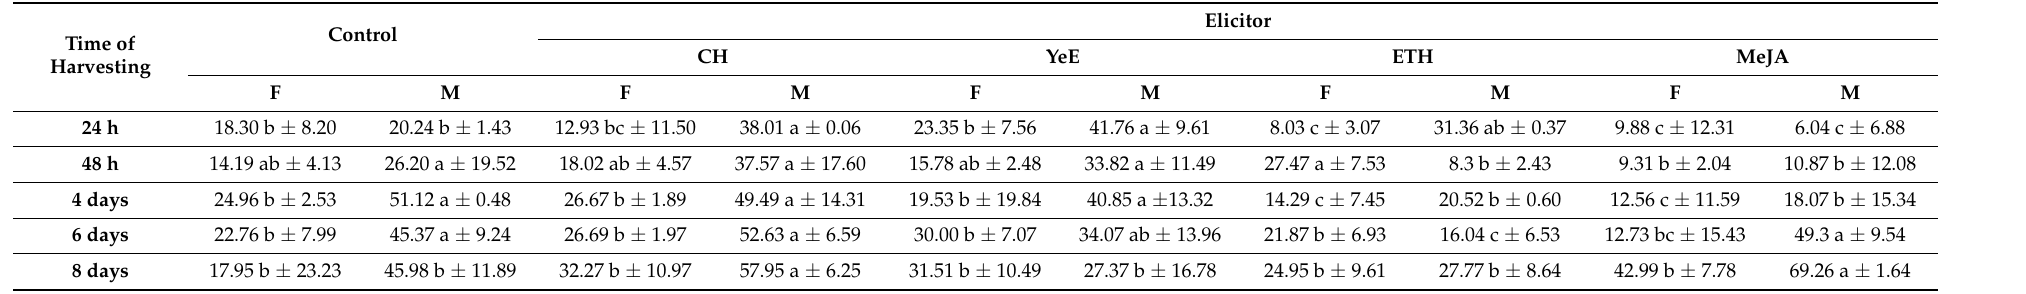
Table 1. Comparison of biomass gains (Gi ± SD) of F and M lines of S. rubriflora agitated cultures depending on harvesting time and the elicitor used. Data expressed as the mean value ± SD ( n = 3). Different superscript letters (a–c) within a row indicate significant differences between means (Duncan’s multiple range test; p <